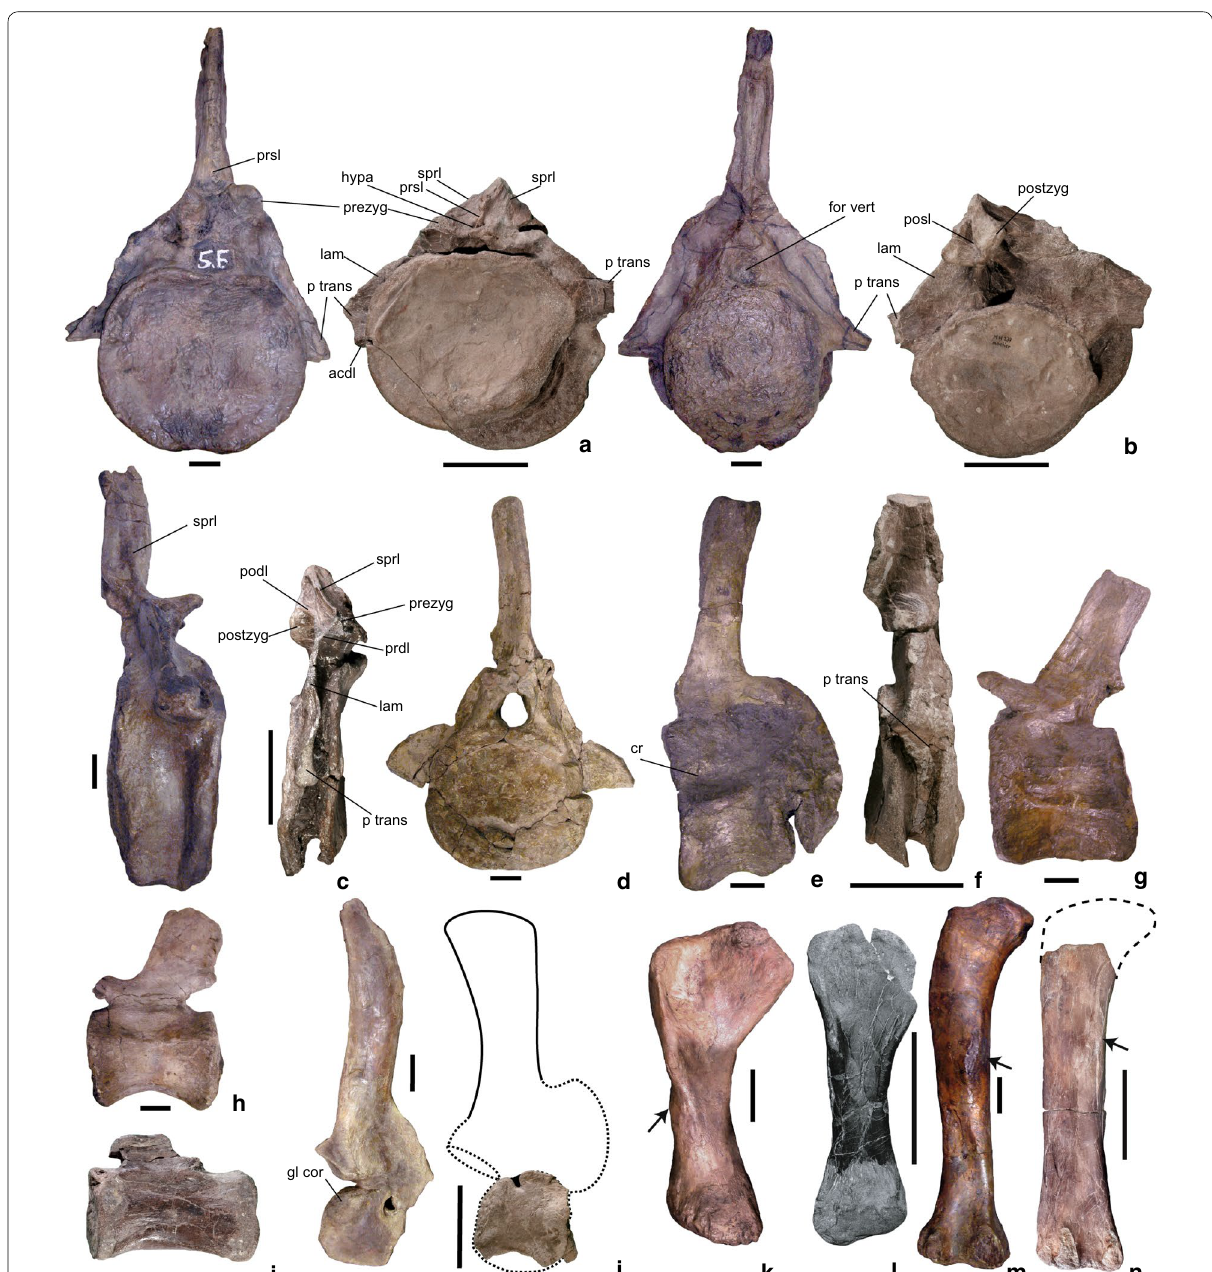
Fig. 18 Comparison of caudal vertebrae of Cetiosauriscus stewarti (BMNH R3078) and “ Cetiosaurus leedsi ” (BMNH R1984) with those of Amanzia greppini . 4th caudal vertebra “5.F.” of C. stewarti and NMB M.H.277 of A. greppini a in anterior, b in posterior and c in lateral aspect. d Anterior caudal vertebra of “ Cetiosaurus leedsi ” (BMNH R1984) in anterior aspect. e 11th caudal vertebra “7” of C. stewarti in lateral aspect. f 12th caudal vertebra M.H.275 of A. greppini (mirrored view for better comparison) in lateral aspect. g) “F.14” ?17th caudal vertebra of C. stewarti in lateral aspect. h “18” 21st caudal vertebra of C. stewarti in lateral aspect. i NMB M.H. 258, 21st caudal vertebra of A. greppini in lateral aspect. j Right scapulocoracoid of Cetiosauriscus stewarti (BMNH R3078) (above) and left coracoid NMB M.H. 284 (below) with hypothetical scapula reconstruction in lateral aspect. k Right humerus of Cetiosauriscus stewarti (BMNH R3078) in anterior aspect with arrow indicating bulge laterally to deltopectoral crest. l Right humerus NMB M.H. 260 of A. greppini in anterior aspect. m Left femur of Cetiosauriscus stewarti (BMNH R3078) in posterior aspect, arrow indicating fourth trochanter. n Left femur of NMB M.H. 372 of A. greppini in posterior aspect, arrow indicating fourth trochanter. Scale bar for a – j is 100 mm, scale bar for k – n is 200 mm. acdl anterior centrodiapophyseal lamina, cr crest, for vert vertebral foramen, gl cor glenoid surface of coracoid, hypa hypantrum, lam lamina, podl postzygodiapophyseal lamina, posl postspinal lamina, postzyg postzygapophysis, prezyg prezygapophysis, prsl prespinal lamina, p trans transverse process, sprl spinoprezygapophyseal